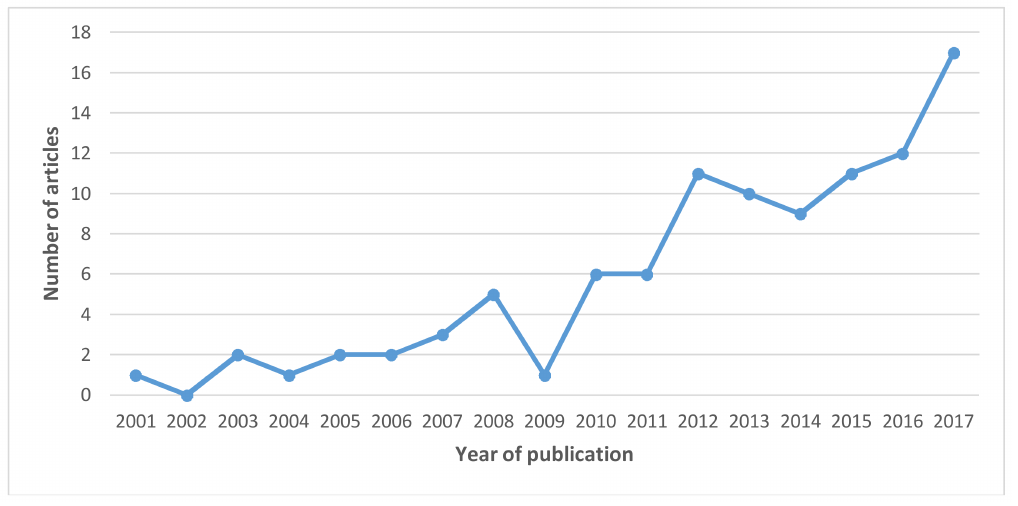
Figure 5. Number of articles found in the literature search by publishing year, up to 2017. No explanation has been found for the low number of articles from